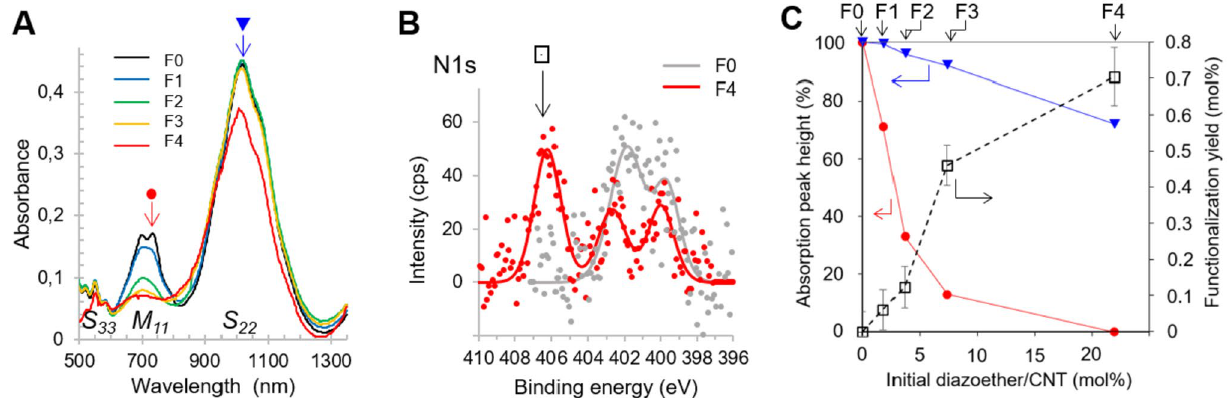
Fig. 1 Characterization of SWCNT samples as a function of func- tionalization degree. A: Background-subtracted absorption spec- tra of the SWCNTs in solution, showing the van Hove peaks of the S transition at 1050 nm (triangle, sc- SWCNTs) and of the M 22 transition at 730 nm (dot, m- SWCNTs). B: N1s XPS spectra of pris- tine (grey) and functionalized (red) SWCNTs, showing the NO